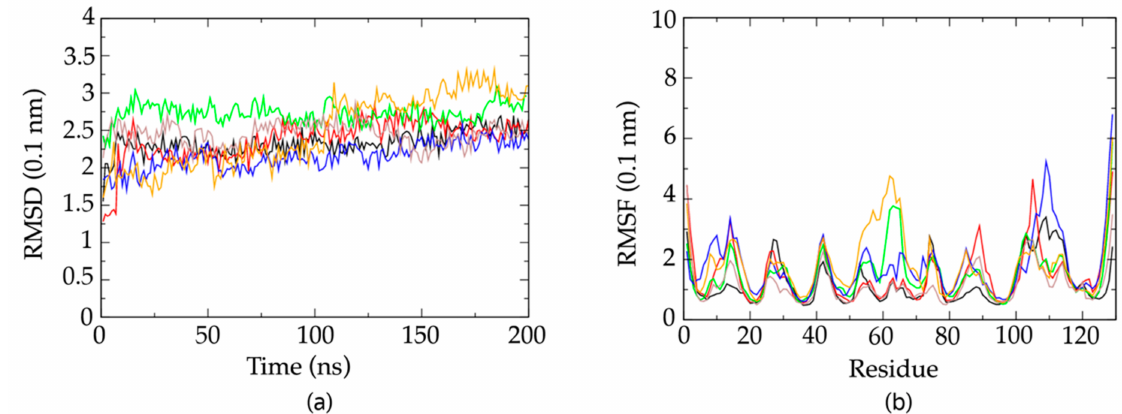
Figure 8. ( a ) RMSD with respect to the lowest energy structure of the NOE − restrained clusters as a function of time of the six MD simulations that were carried out starting from the minimized representative structures from the six clusters of the NOE − restrained PONDEROSA C/S models of Nb23. Black trace = cluster 1 (11 members); red trace = cluster 2 (2 members); green trace = cluster 3 (2 members); blue trace = cluster 4 (1 member); orange trace = cluster 5 (1 member); pale brown trace = cluster 6 (1 member). ( b ) RMSF in the same six MD simulations as in panel ( a ), as a function of the residue number of Nb23. The color code of the traces is the same as in panel ( a